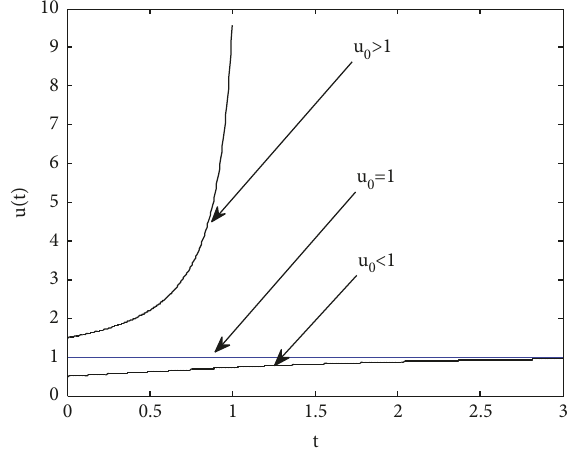
Figure 1: The solution of the equation 𝑢 𝑡 = 𝑢|1 − 𝑢| for the initial conditions 𝑢 0 < 1 , 𝑢 0 = 1 , and 𝑢 0 > 1